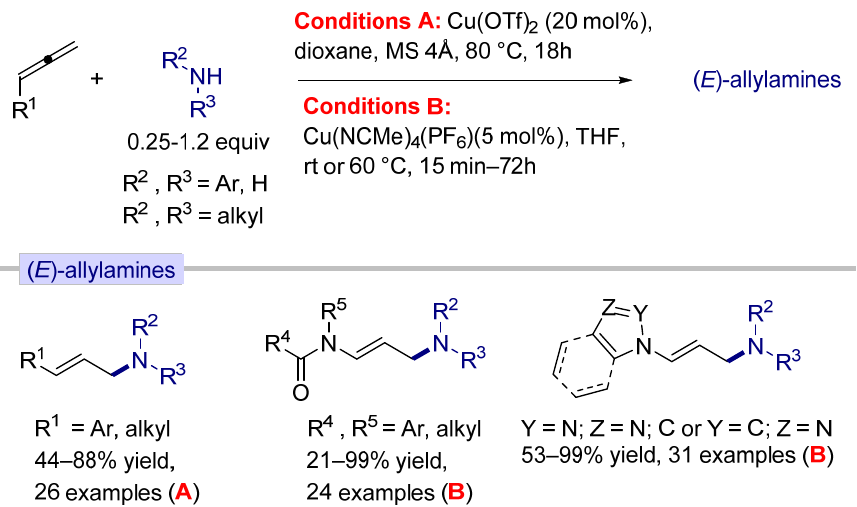
Figure 23. Regio- and stereoselective Cu(II)-catalyzed intermolecular hydroamination of terminal allenes. rt = room temperature.